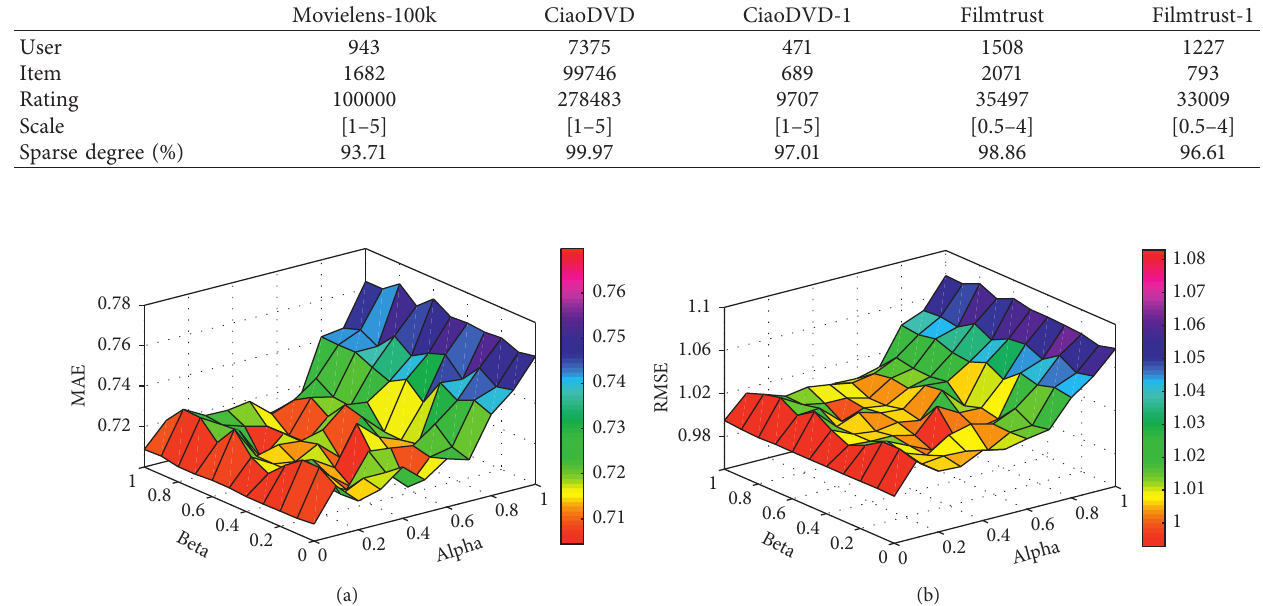
Figure 3: Movielens. (a) MAE results of different values of α and β . (b) RMSE results of different values of α and β